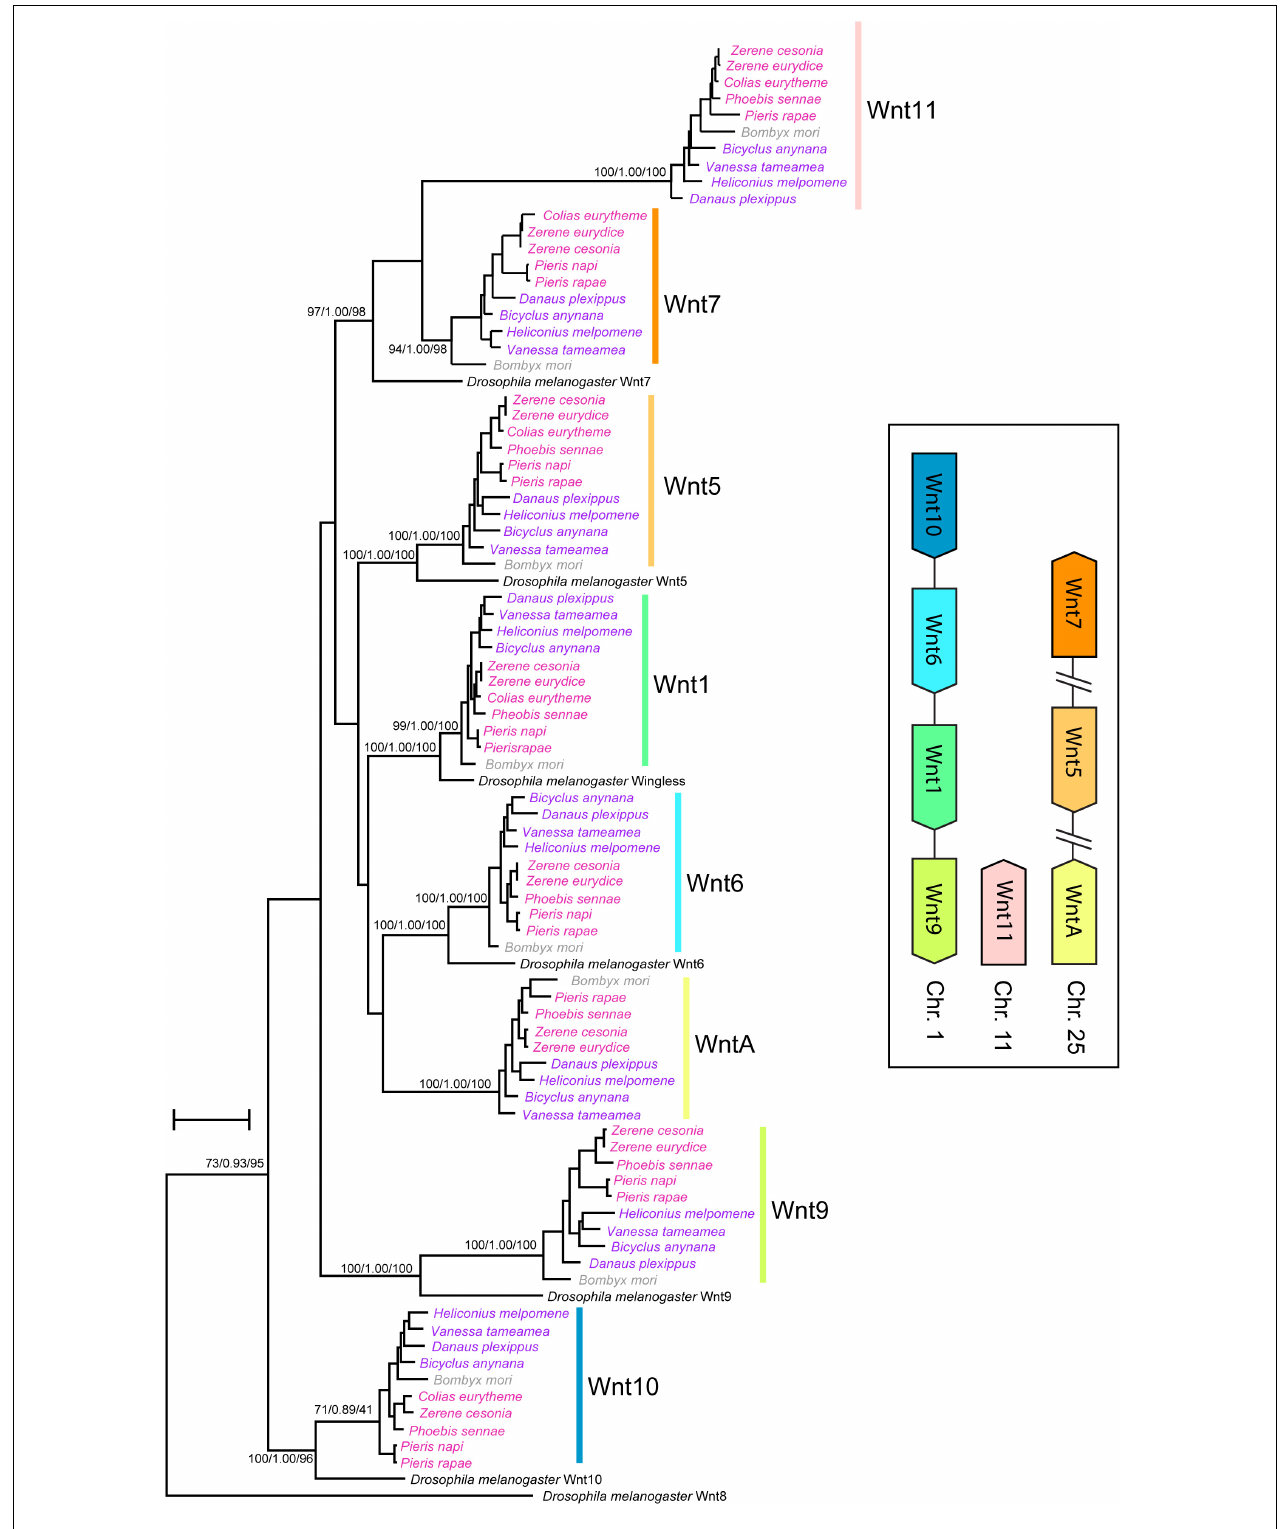
FIGURE 1 | Wnt gene content and synteny in butterfly genomes. Phylogenetic analyses reconstruct clades for each of eight Wnt genes present in lepidoptera genomes. Inset shows chromosomal linkage and order of Wnt genes in Z. cesonia genome assembly ( Supplementary Table S1 ), which is known to vary within clusters across Lepidoptera (Holzem et al.,